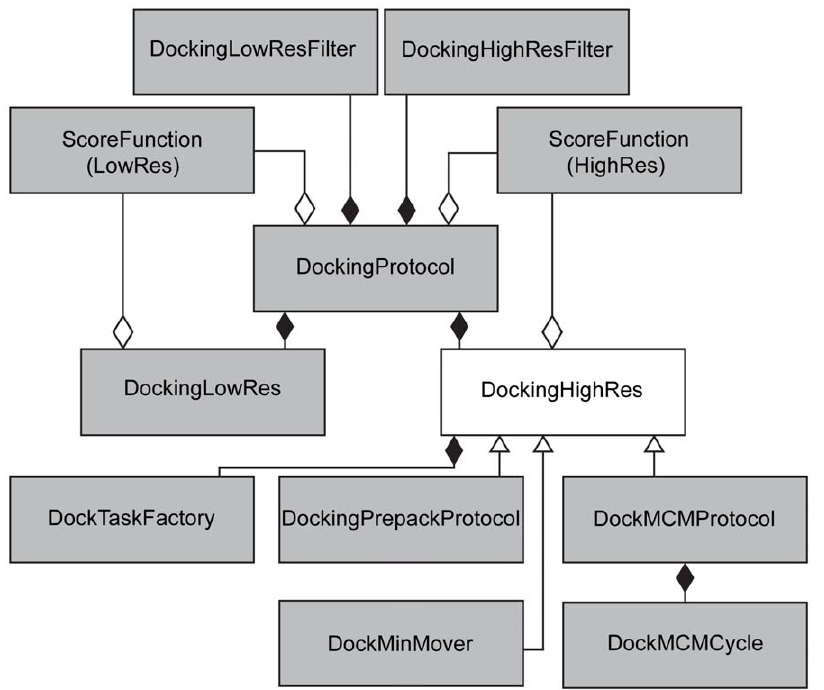
Figure 2. Structure of major classes associated with docking. A shaded diamond indicates composition (the object the diamond points towards is responsible for the lifecycle of the other object); an open diamond indicates aggregation (the object the diamond points towards has an instance of the other object but it may not be solely responsible for that instance’s lifecycle); and an open triangle indicates a class hierarchy with the triangle pointing towards the parent